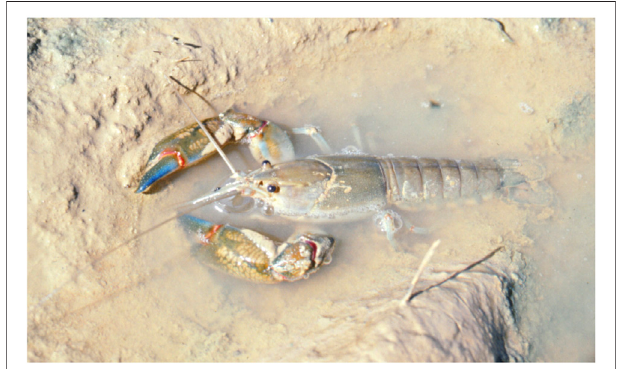
FIGURE 1 | Adult Cherax destructor . Photo provided by Christopher